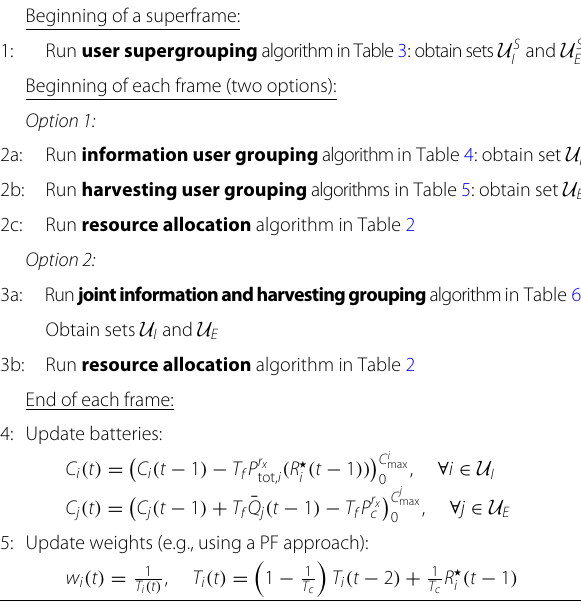
Table 7 Overall user grouping and resource allocation